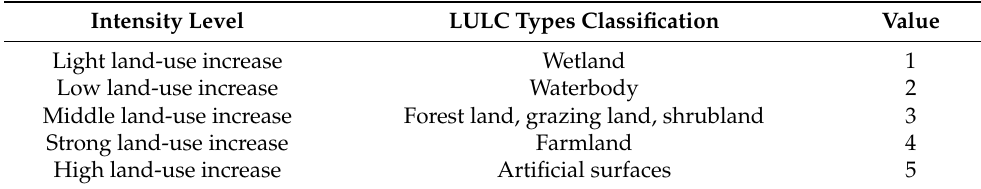
Table 2. Stages of measurement of land-use intensity.